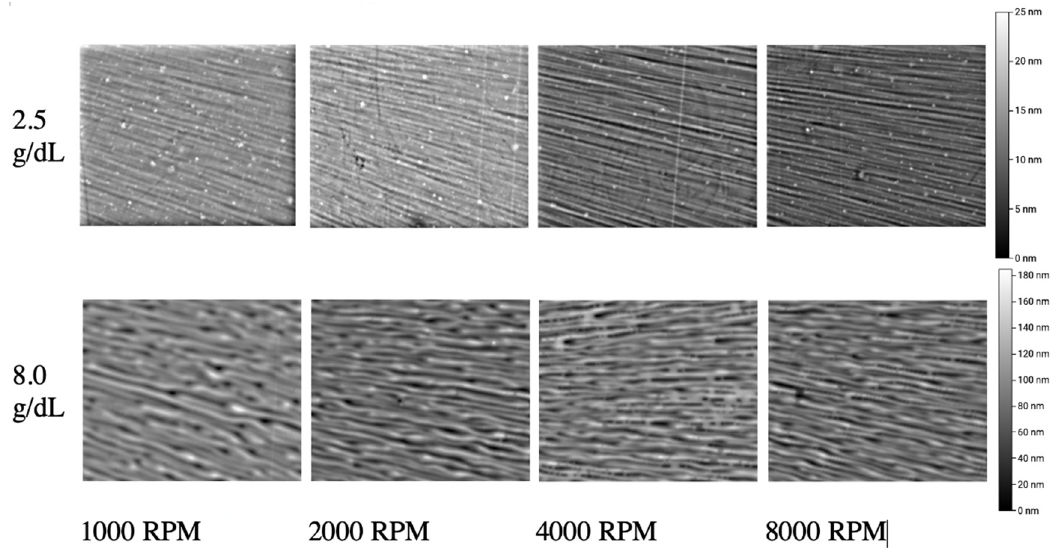
Figure 5. Optical micrographs of PMMA thin films cast at different spin speeds from chosen solution concentrations. The micrographs are taken at least 4 mm away from the center of the film where the wrinkle patterns are well developed. Films were prepared from solutions ranging in concentration from 2.5 g/dL to 8.0